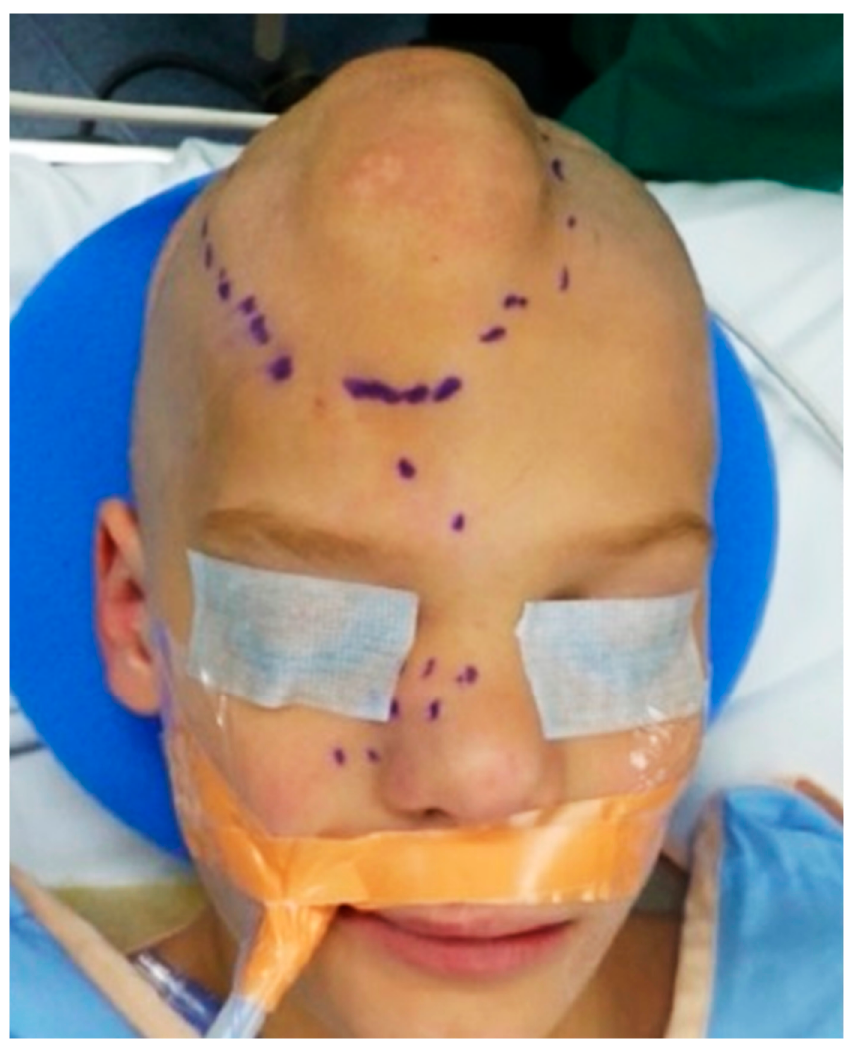
Figure 1. Ill-defined soft tissue mass in the patient’s forehead showing local extension to the scalp and inferiorly to the nose bridge and right lateral aspect of the nose.